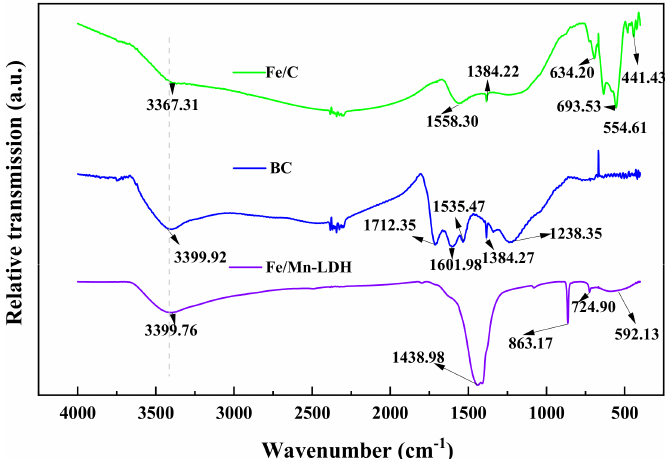
Figure 4. The FT-IR spectra of Fe/C, BC and